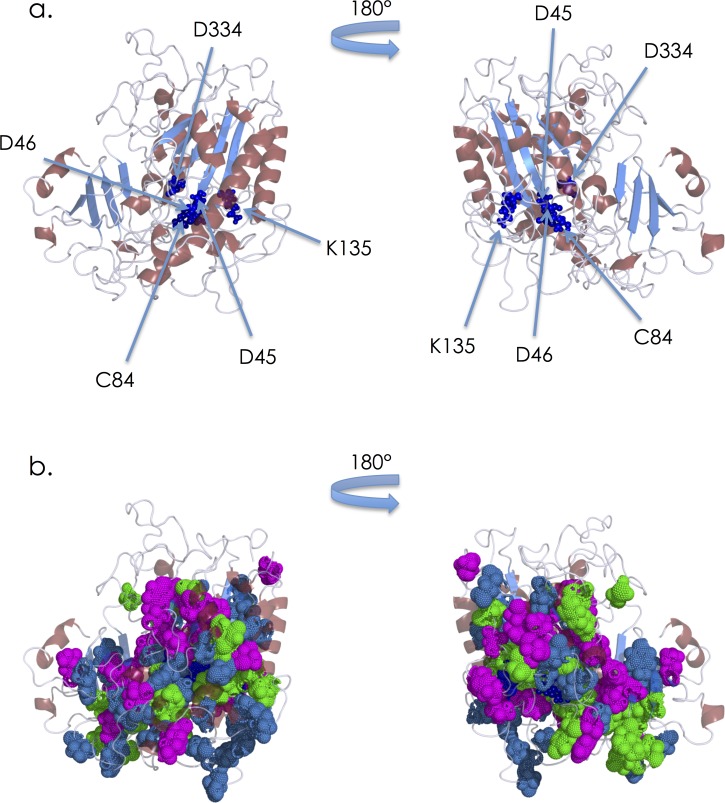
Predicted structure of human IDS (a), and positions of amino acid residues where substitutions responsible for MPS II have been identified (b). The backbone is displayed as a ribbon model. (a) IDS is colored according to the secondary structure. Helices are colored red, sheets blue, and loops gray. The residues comprising the putative active site (D45, D46, C84, K135, and D334) are presented as small dark blue spheres. (b) The residues involved in substitutions responsible for MPS II are presented as spheres (severe: magenta, attenuated: blue, and both: green).